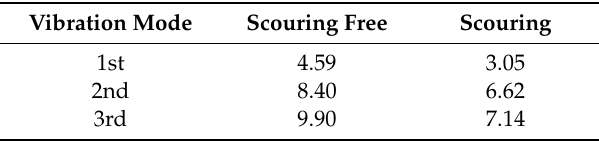
Table 4. Modal frequencies of pier models (Unit: Hz).